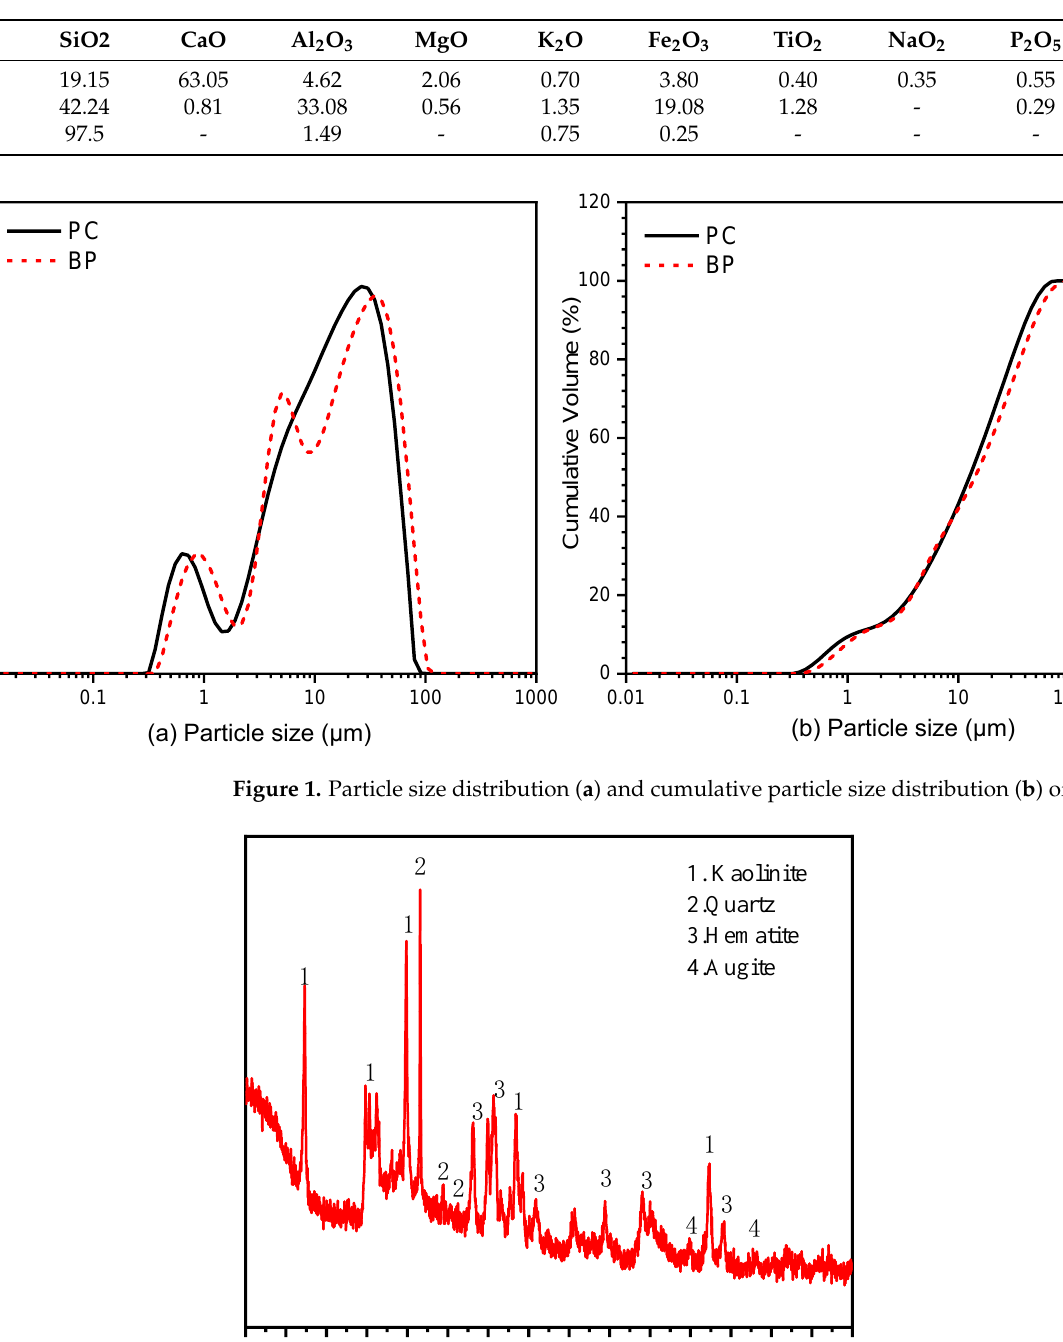
Figure 3. Morphology of OPC( a , b ) and BP ( c , d ). 2.2. Zeta Potential Test The formation of hydration products, inter-particle force in fresh cement paste, and the interface strength between the stone powder and hydrates are significantly affected by the surface charge properties of particles [24,25]. To compare the surface chemical properties of OPC and BP, zeta potential tests were applied. However, cement dissolves in the simulated solution, and its zeta potential is difficult to determine. It is mentioned in the literature [22,23] that the potential and morphology of quartz are similar to that of